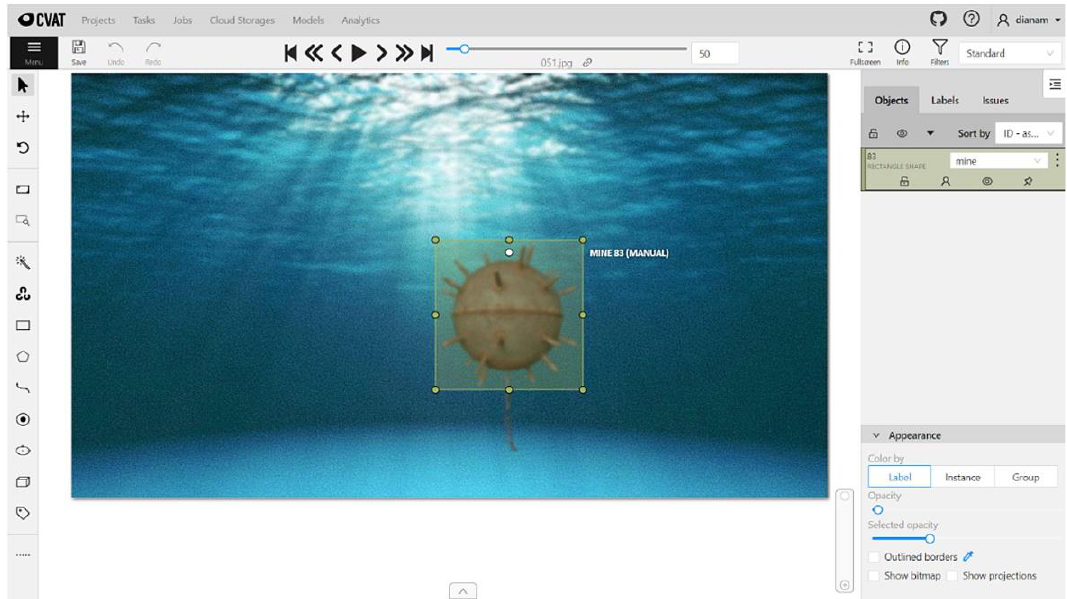
Figure 10. CVAT image annotation — naval mines for submarines.